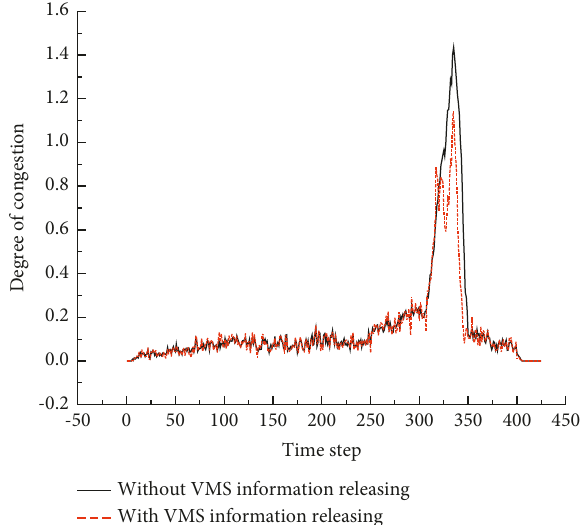
Figure 22: The change of congestion degree of the road section (20, 19) during traveling for the scenario of ingress.